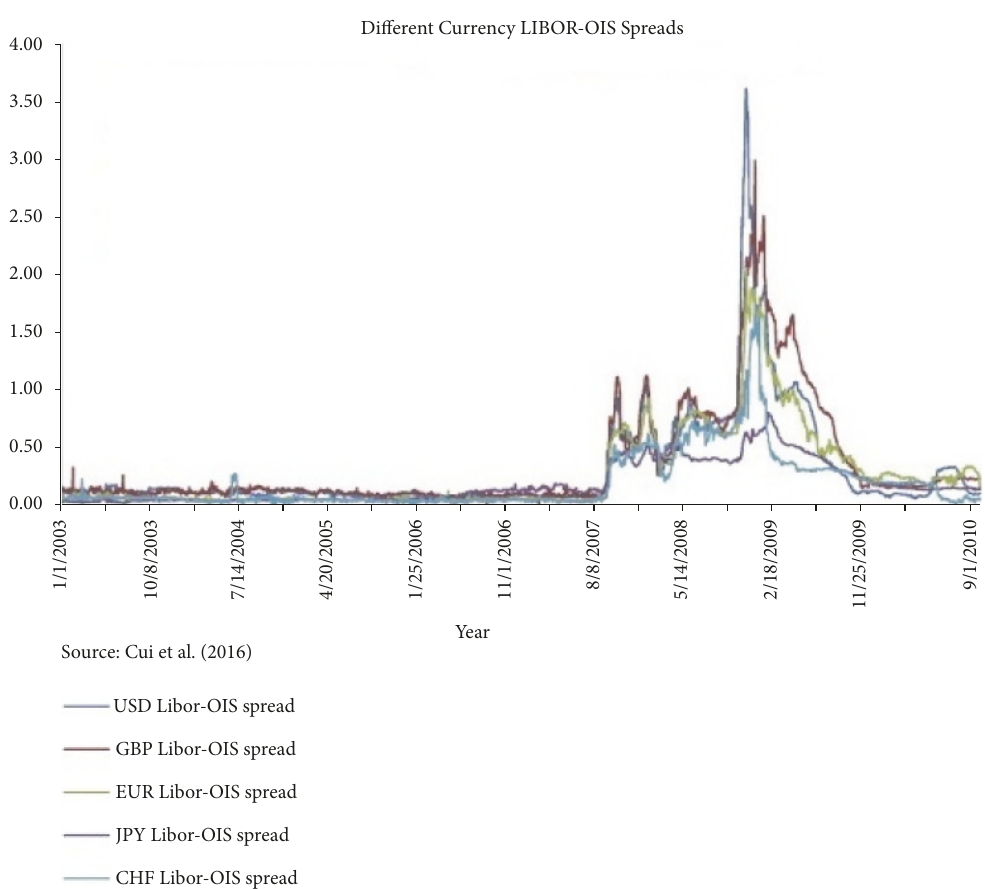
Figure 1: Different Currency LIBOR-OIS